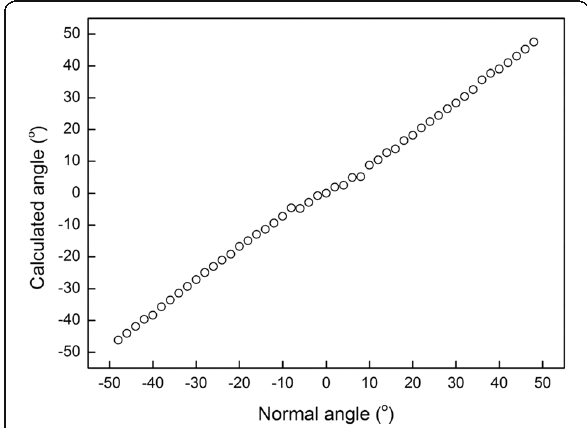
Fig. 5 Calculated angle as a function of nominal angle displayed by the TEM